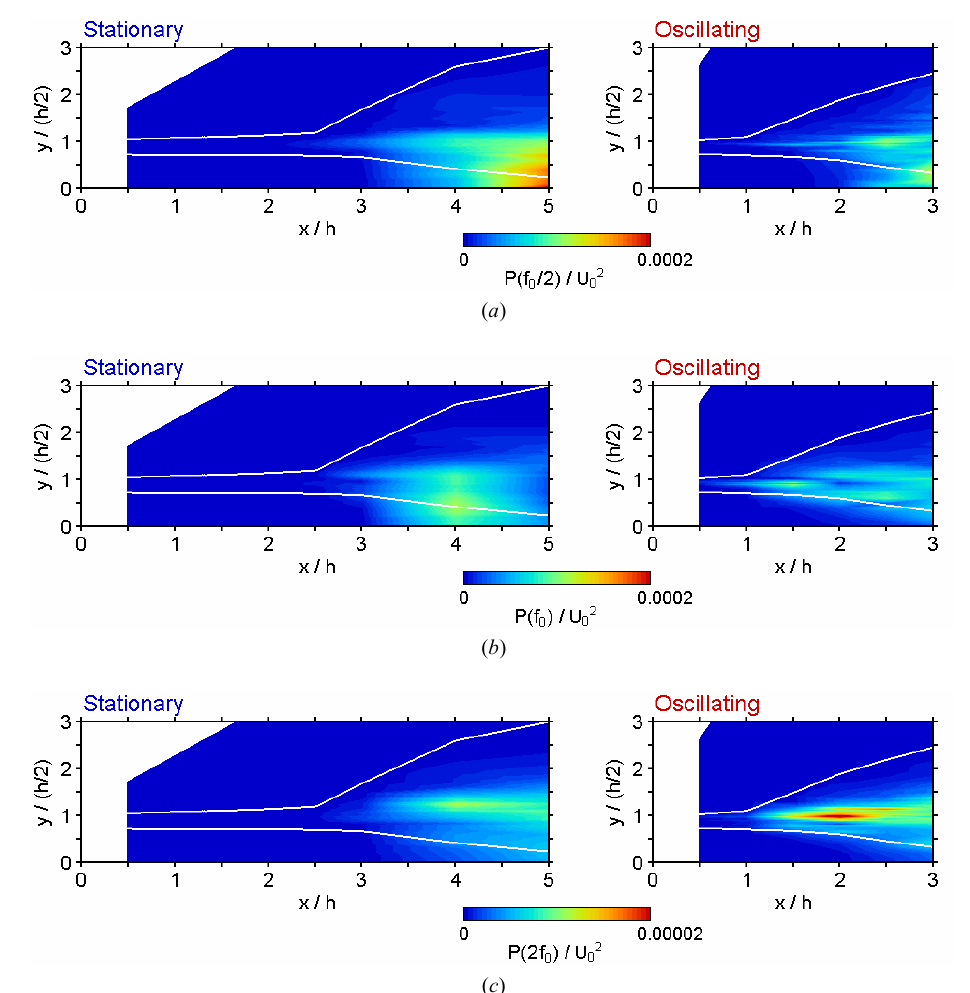
Fig. 4 Isocontour maps of power spectrum density of fluctuating velocity in the streamwise component at subharmonic, fundamental and harmonic frequencies: ( a ), subharmonic; ( b ), fundamental; and ( c ), harmonic